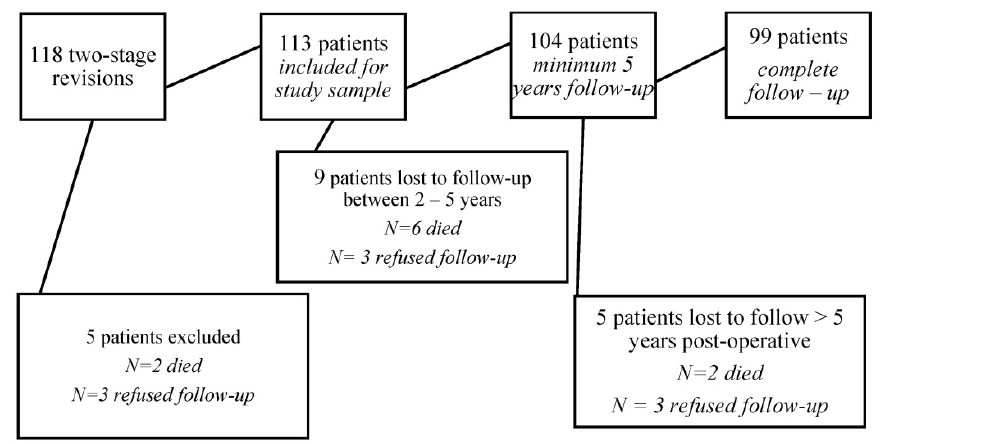
Figure 1: Flow diagram for patient inclusion and exclusion and patients lost to follow-up.